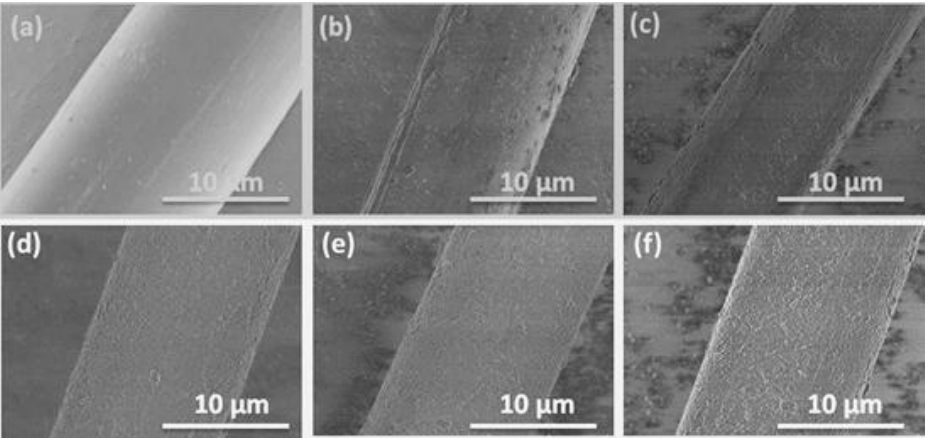
Figure 8. Surface morphology of aramid fibers before and after treatment with layer-by-layer self-assembly of L -PDOPA: ( a ) AF; ( b – f ) nL-AF (n: 1, 2, 3, 4, 5).